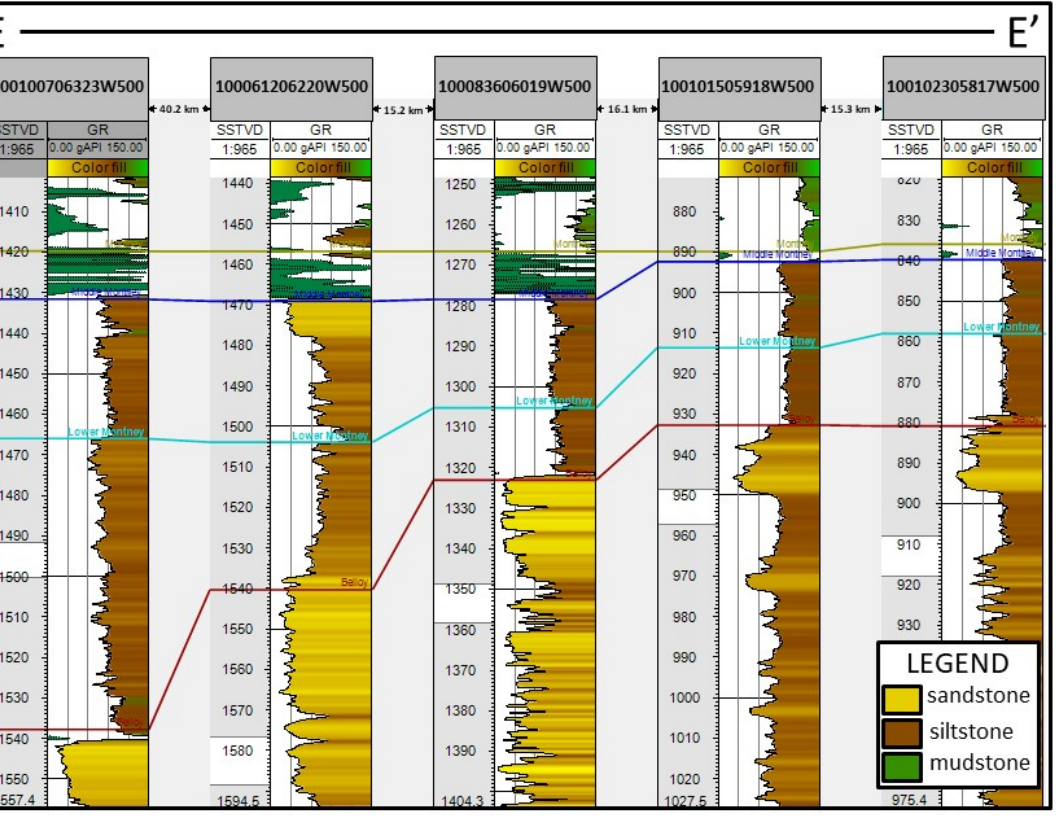
Figure 32. NW-SE cross-section along the depositional strike near the Fox Creek area. See Figure 24 for the location of the cross-section E–E ′ . The Upper Montney Top is the brownish yellow line, the Middle Montney Top is the dark blue line, the Lower Montney Top is the light bluish green line, and the base of the Montney at the Belloy Top is the dark red line. The thickness of the Montney Formation is most likely to be affected by the Fox Creek escarpment, and the thickness is greater in the northern sections, which correlates with the higher TOC and HI content and the lower gas dry- ness composition. The kerogen type may be responsible for the change in gas composition in this area, with more type I and II kerogen generating longer-chained hydrocarbons.